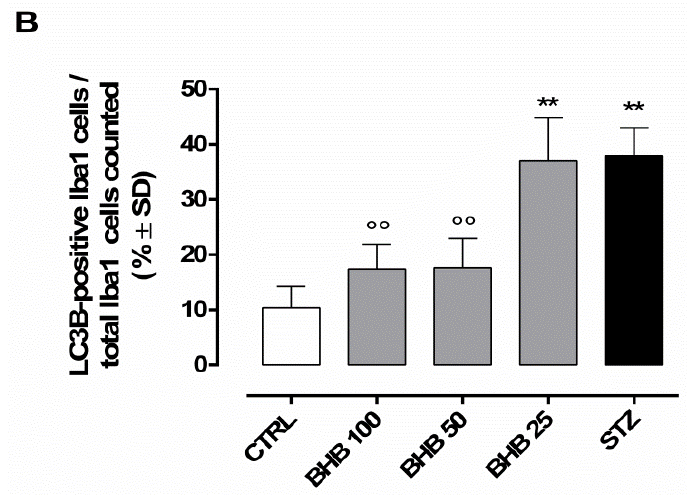
Figure 5. Detection of LC3b immunolabeling in Iba1-positive microglia ( A ) and relative graph ( B ) in non-diabetic mice (CTRL), diabetic mice (STZ), and diabetic mice treated with BHB 25 mg/kg (BHB 25), 50 mg/kg (BHB 50), and 100 mg/kg (BHB 100). ( A ) Sagittal retina sections of visible retinal pigment epithelium (RPE) and outer nuclear layer (ONL), showing the higher co-localization (arrow) of Iba1 (red) and LC3B (green) in the ONL of STZ and BHB 25 groups. Magnification ×63. ( B ) Graph expressing the percentage (%) of LC3B-positive Iba1 cells on total Iba1 cells counted. The results are reported as mean ± SD of N = 8 retinas per group. ** p < 0.01 vs. CTRL; °° p < 0.01 vs. STZ. BHB treatment at 50 mg/kg and 100 mg/kg markedly reduced the co-localization between Iba1 and LC3B, showing a reduction of M1 microglial autophagy in ONL (BHB 50: 17.6 ± 5%, p < 0.01 vs. STZ; BHB 100: 17.4 ± 5%, p < 0.01 vs. STZ) (Figure 5A,B). 2.7. HCA 2 Blocking by Pertussis Toxin (PTX) Abolishes BHB Effects on BDNF and Cnx43 The blocking of the HCA 2 receptor by PTX (1 µg) i.p. administration to diabetic mice markedly reduced the retinal BDNF (43 ± 5 pg/mL, p < 0.01 vs. CTRL), also when combined with BHB 25 mg/kg (38 ± 4 pg/mL), 50 mg/kg (42 ± 4 pg/mL), and 100 mg/kg (43 ± 4 pg/mL) in diabetic animals (Figure 6A).